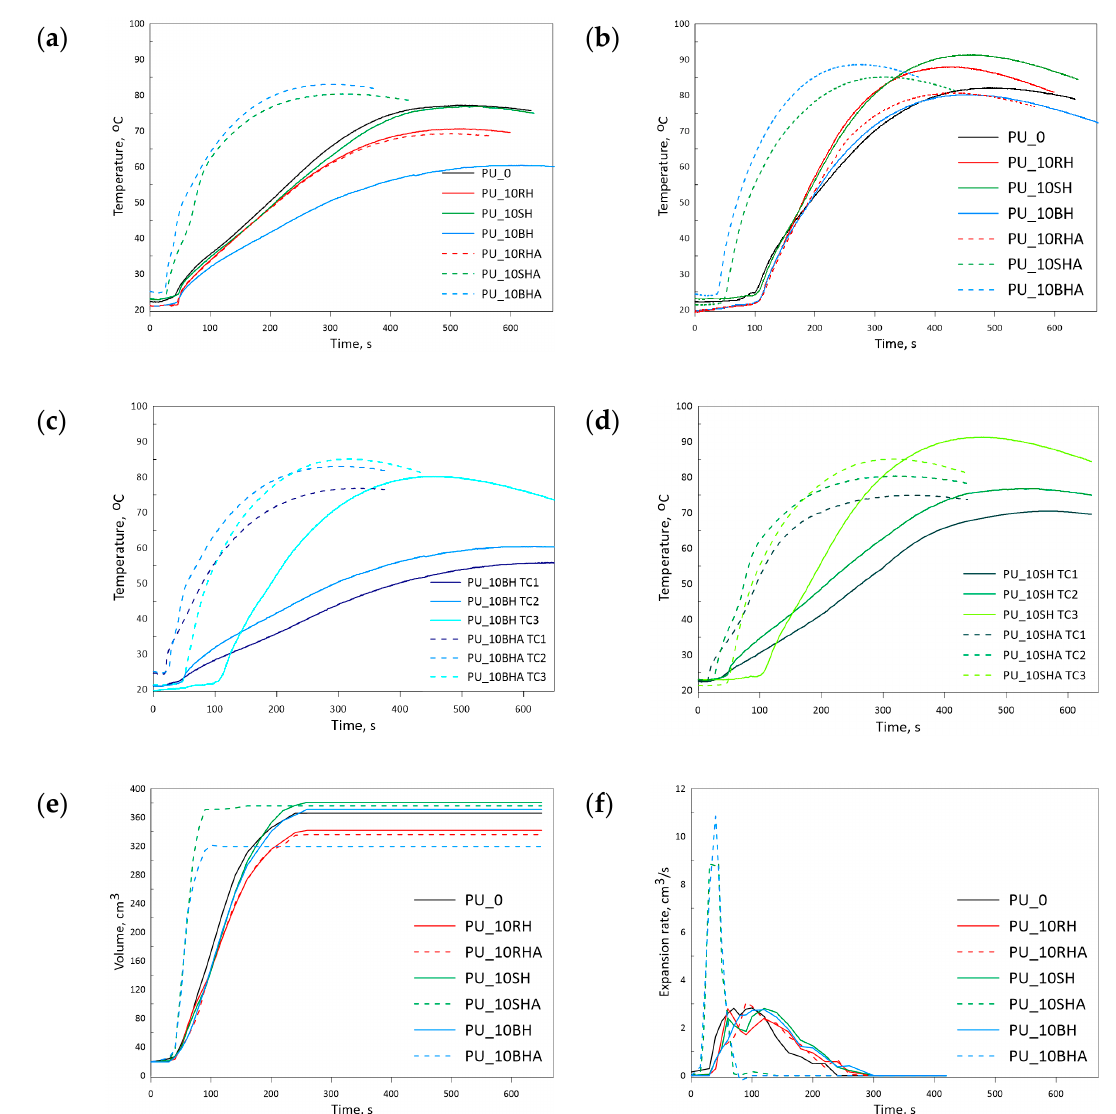
Figure 5. Temperature recorded by TC2 ( a ) and TC3 ( b ) for all samples; temperature recorded by TC1, TC2 and TC3 for BH and BHA ( c ) and for SH and SHA ( d ) samples; determined volume for all samples ( e ); and expansion rate for all samples ( f ).